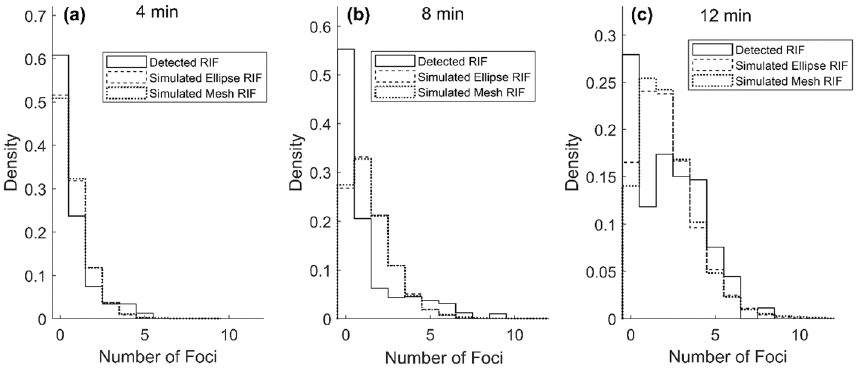
Fig. 8 Detected RIF distribution compared with simulated RIF distributions for the elliptical cylinder phantom and mesh volume phantom, respectively. Results for 4 min ( a ), 8 min ( b ), and 12 min ( c ) of alpha 241 Am source